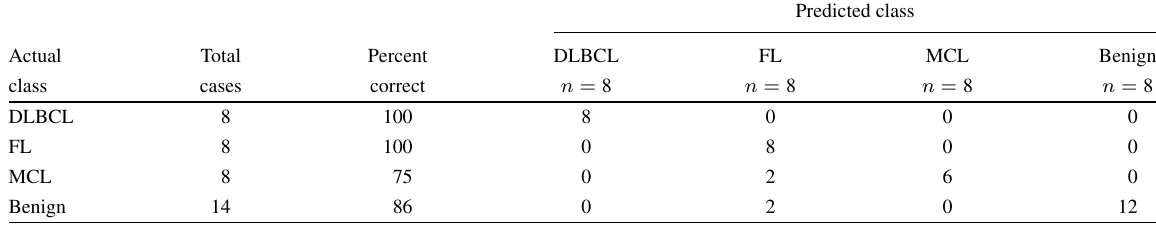
Classification results for the supervised classification algorithm. The actual classification results for the generated supervised algorithm are shown (Table 1A) together with the predicted classification results (Table 1B), obtained after V-fold cross validation